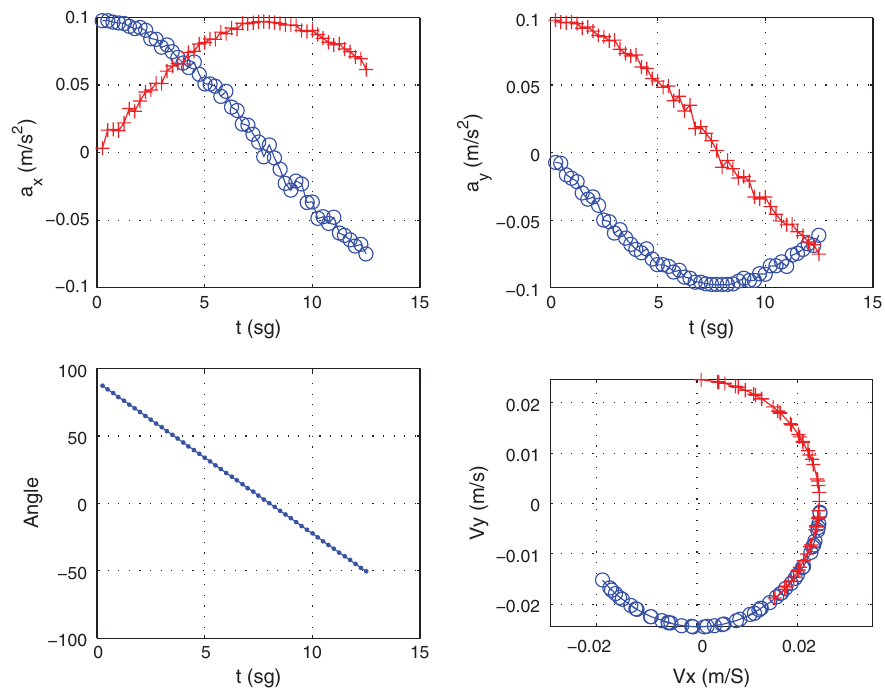
Fig. 4. Inertial frames descriptive model (12) yielded results of accelerations represented in two inertial frames, local frame (blue circles), and global frame (red crosses), with ψ = π and θ t 2